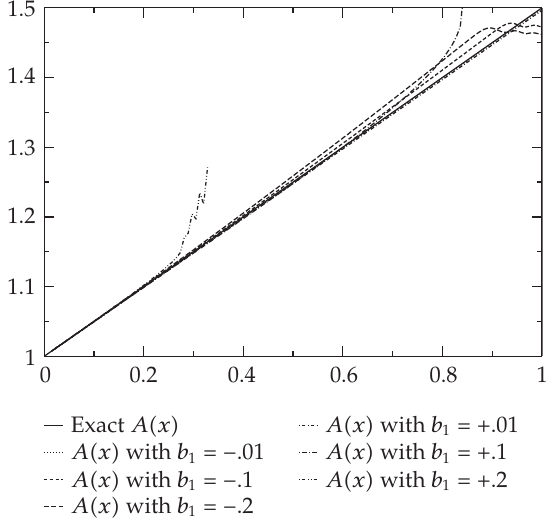
Figure 7.1 . The reconstructed cross-sectional area A ( x ) = 1 + . 5 x for various b 1 values using n = 128 grid points.